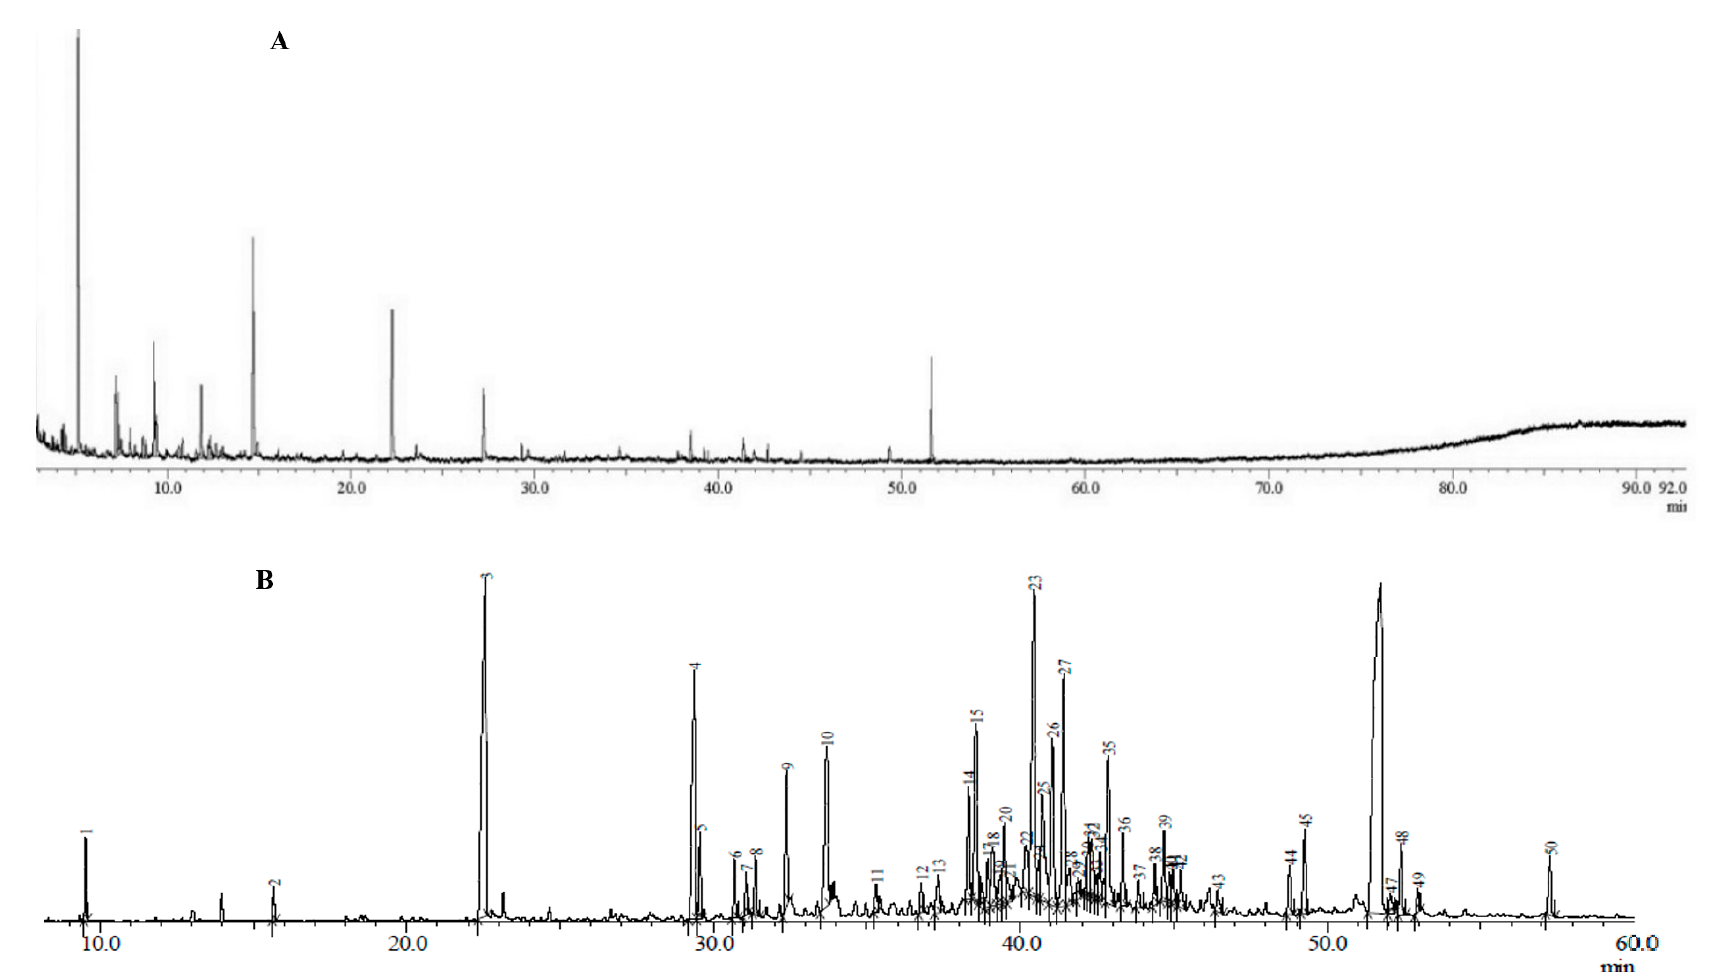
Figure 4. GC / MS chromatogram of A. malaccensis wood essential oil extracted by ( A ) SCWE and ( B ) Hydrodistillation.